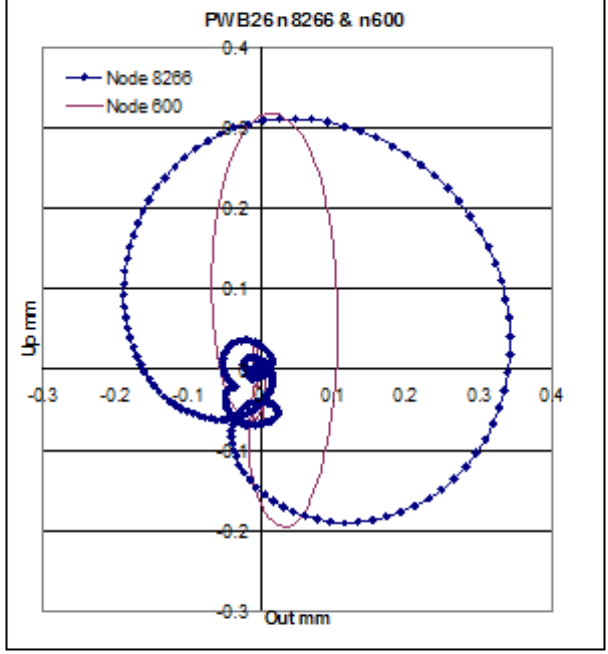
Figure 14. This hodograph plots vertical and horizontal motions against one another.